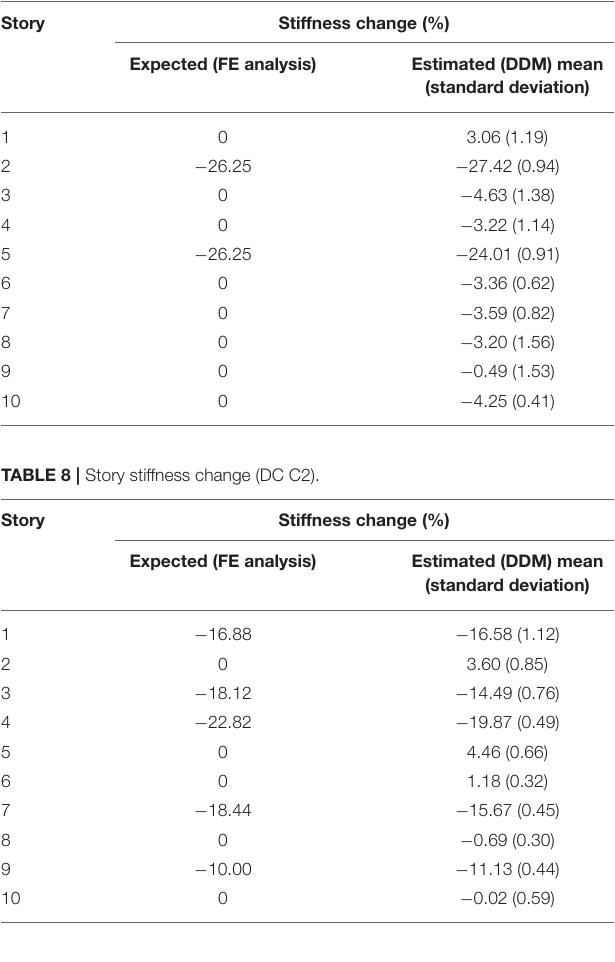
TABLE 9 | Story stiffness change (DC